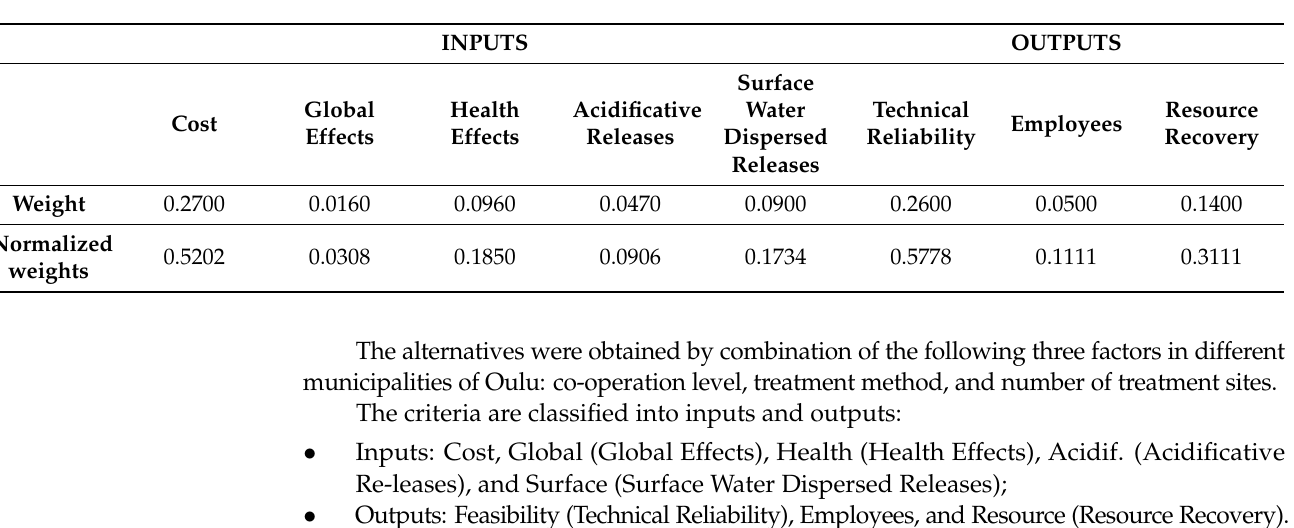
Table 2. Criteria weights in